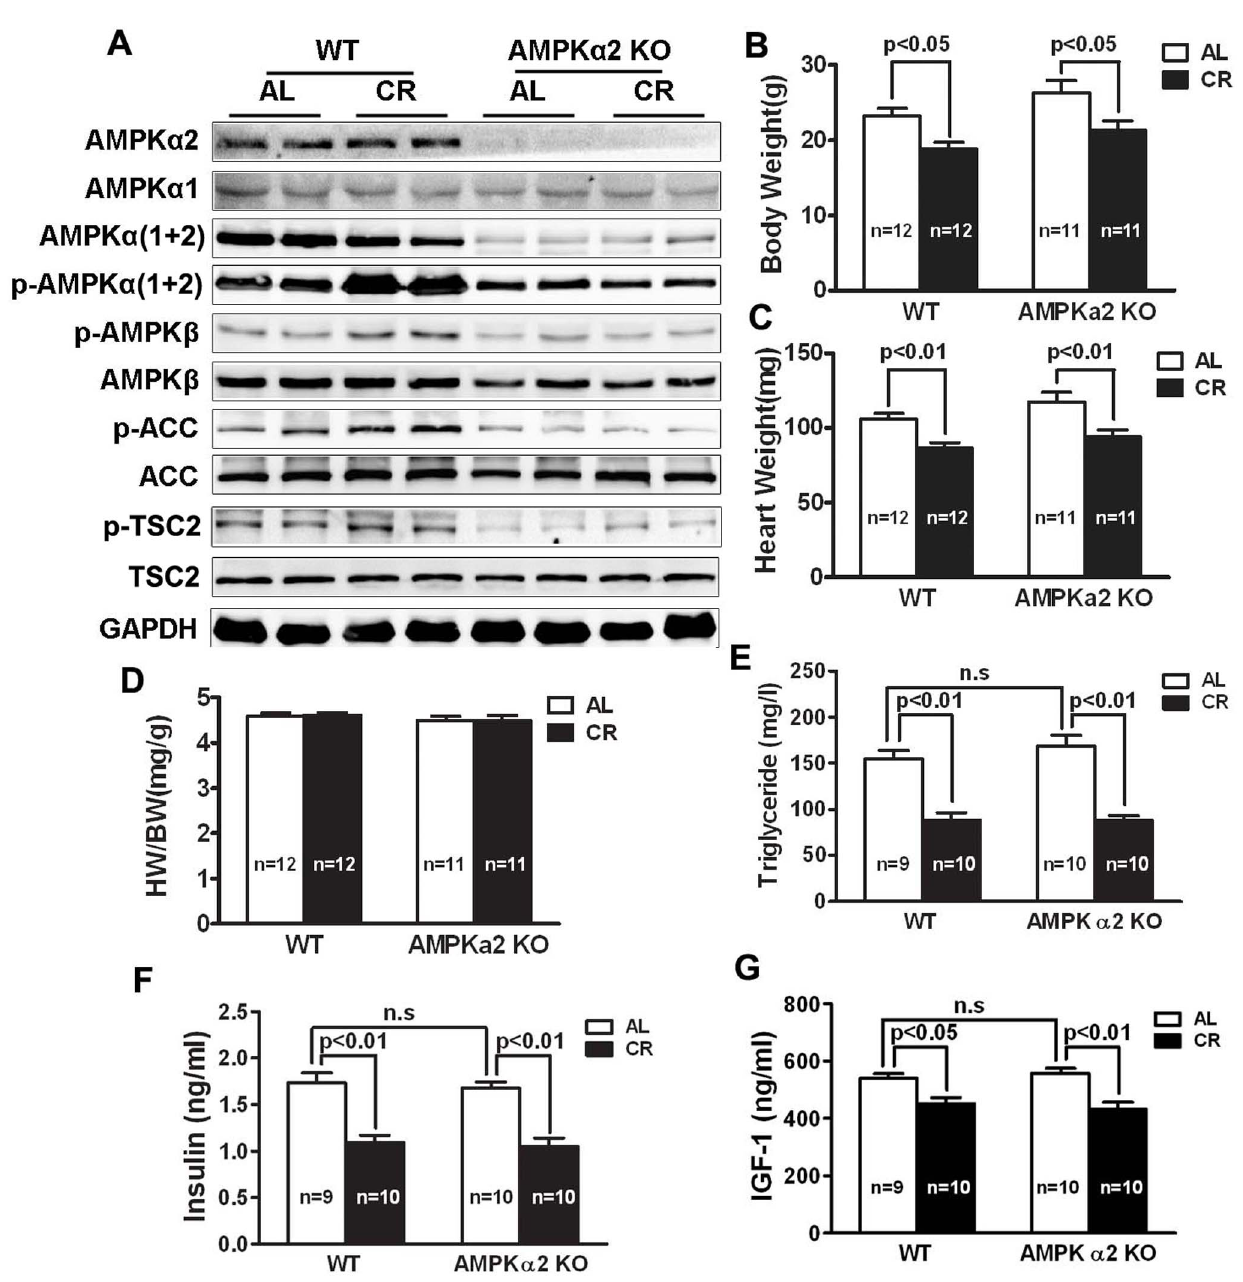
Figure 1. General effects of CR on AMPK a 2 KO mice and their WT littermates. Both AMPK a 2 KO mice and C57B/6 WT littermates were either fed ad libitum (AL) or subjected to CR (mice were allocated 20% less food than AL for 2 weeks and 40% less for another 2 weeks). Western blot analysis of cardiac proteins was performed to assess the total protein levels and the phosphorylation states of AMPK a 1/2 and b subunits as well as its downstream target acetyl-CoA carboxylase (ACC) and TSC2 ( A ). Note: the antibodies against AMPK a and p-AMPK a can recognize both a 1 and a 2 isoforms. Other parameters indicative of the effectiveness of the CR protocol include body weight (BW, B ), heart weight (HW, C ), HW/BW ratio ( D ), blood triglycerides ( E ), and serum levels of insulin ( F ) and IGF-1 ( G ). Data areexpressed as mean 6 SE and analyzed by two-way ANOVA. Sample sizes were indicated in the bar graphs.